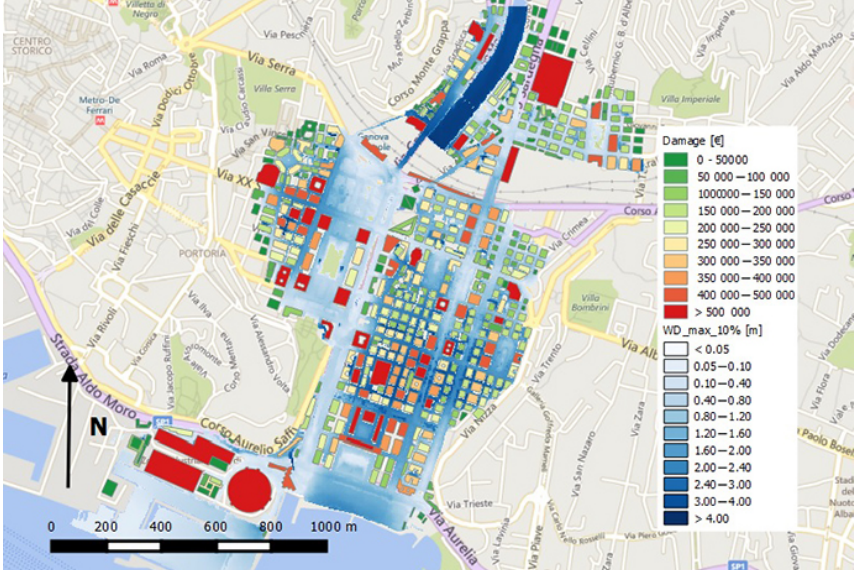
Figure 9. Perc10 scenario, inundation map and damage estimation. In blue scale the water level is reported. The damage is estimated at building scale in EUR; the color scale ranges from low damage (green) to high damage